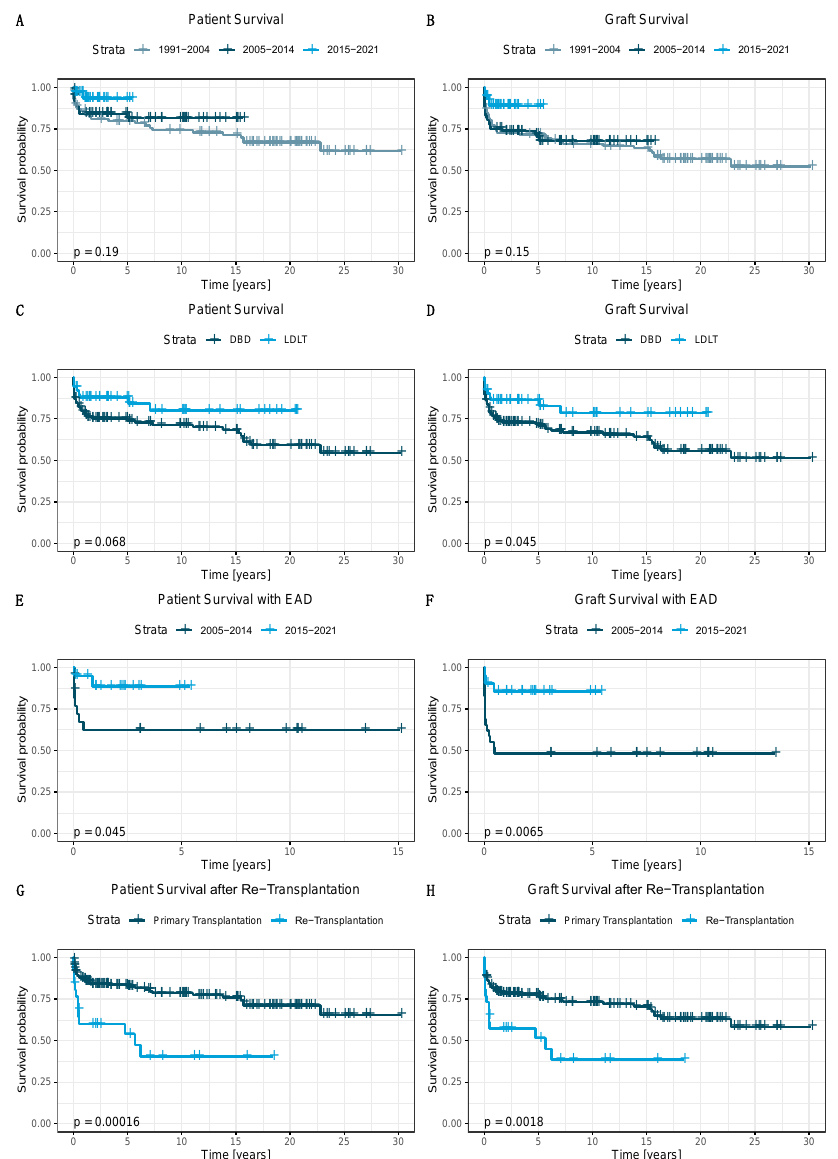
Figure 2. Patient and graft survival after pediatric liver transplantation. p -value: log-rank comparison of survival curves. ( A ) Patient survival compared over three cohorts. ( B ) Graft survival compared over three cohorts. ( C ) Patient survival in Living Donor Liver Transplantation and Donation after Brain Death Transplantation. ( D ) Graft survival in Living Donor Liver Transplantation and Donation after Brain Death Transplantation. ( E ) Patient survival in patients with early allograft dysfunction in the last two cohorts. ( F ) Graft survival in patients with early allograft dysfunction in the last two cohorts. ( G ) Patient survival after re-transplantation. ( H ) Graft survival after retransplantation. Abbreviations: Early Allograft Dysfunction (EAD), Donation after Brain Death (DBD), Living Donor Liver Transplantation